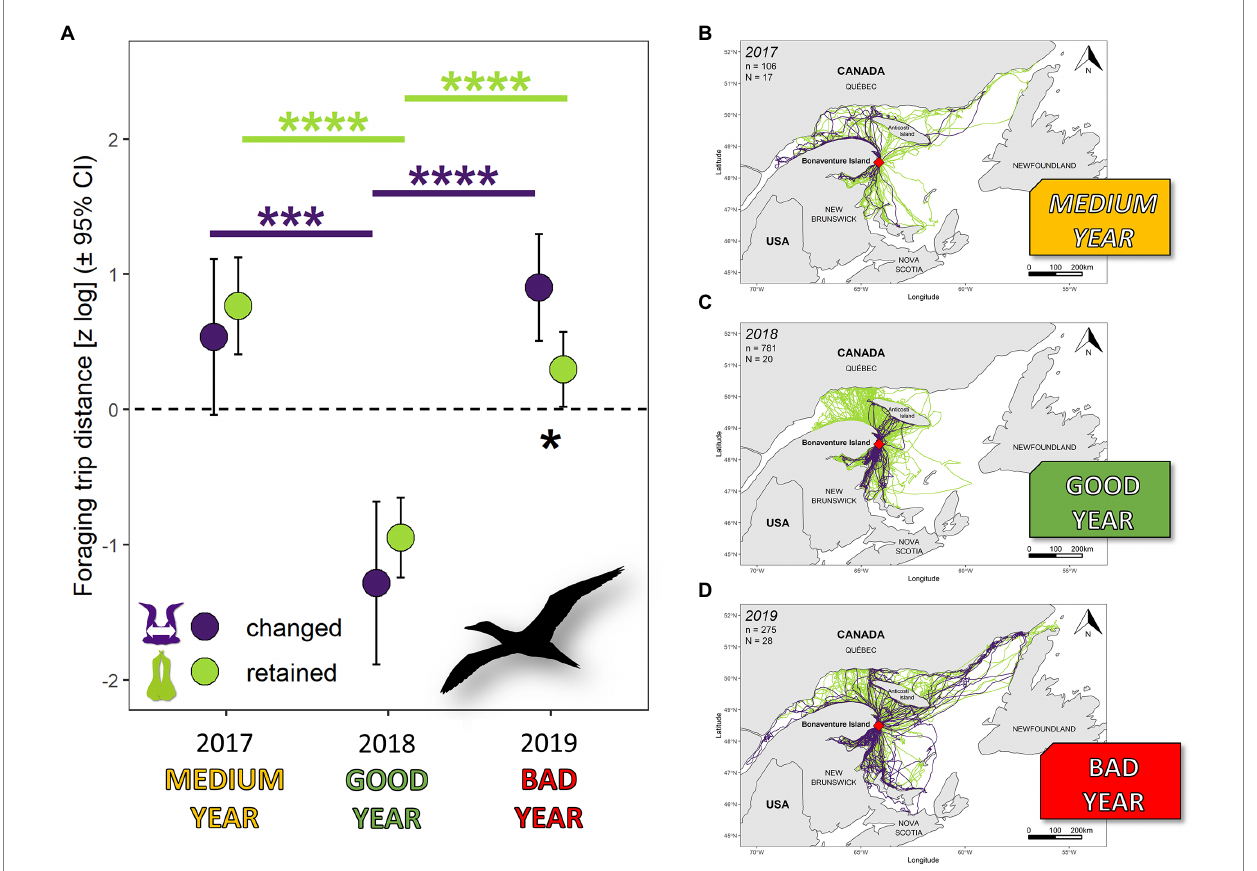
FIGURE 1 Variation in foraging trip distance during breeding season by northern gannets that changed or retained their mates in 2017 ( N = 16), 2018 ( N = 20), and 2019 ( N = 28). Results at left (A) are estimated marginal means (±95% CI) by year obtained from a mixed linear model with year and partnership status:year interaction as fixed parameters and bird ID as random parameter. Data were log-transformed and standardized (* p < 0.05; *** p < 0.001; **** p < 0.0001). Maps on the right side show the total foraging trips recorded each year with GPS devices: (B) 2017 = medium year (breeding success in the colony: 43%), (C) 2018 = good year (breeding success: 60%), and (D) 2019 = bad year (breeding success: